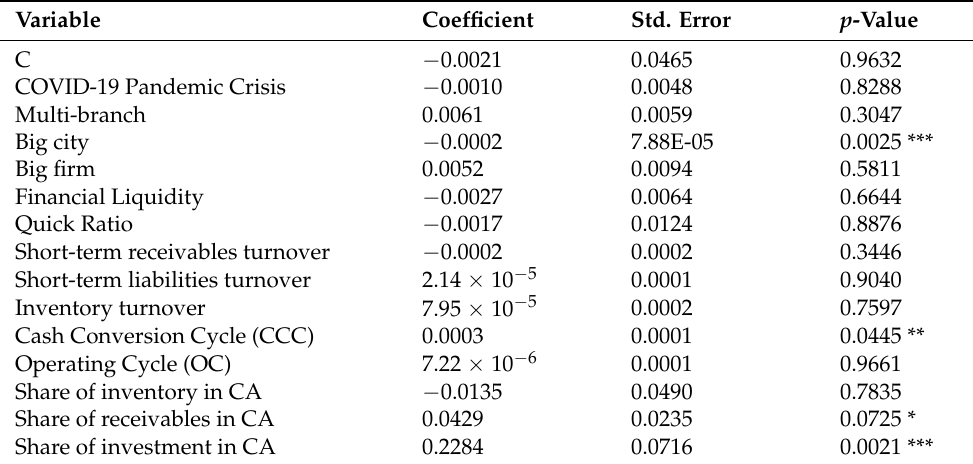
Table 12. The results of the twelfth research